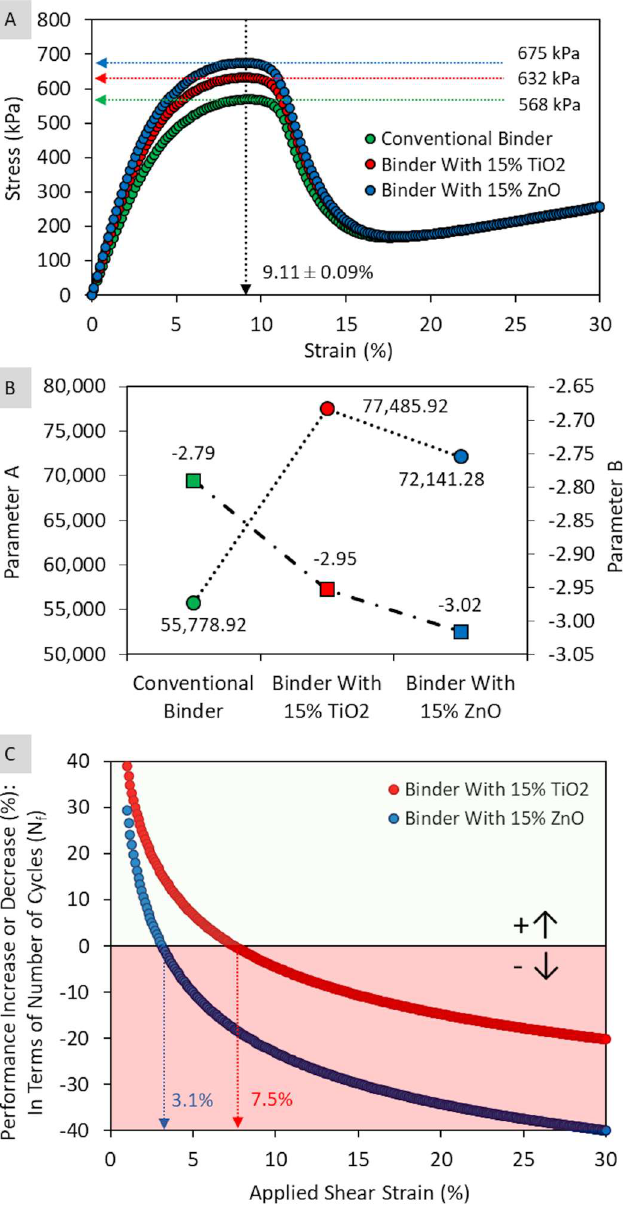
Figure 8. Results of the LAS test (20 °C): ( A ) stress-strain curve, ( B ) parameters A and B of the fatigue model, and ( C ) effect of the type of nanoparticle on the damage tolerance of the asphalt matrix (increase or decrease in performance) as a function of the deformation amplitude.